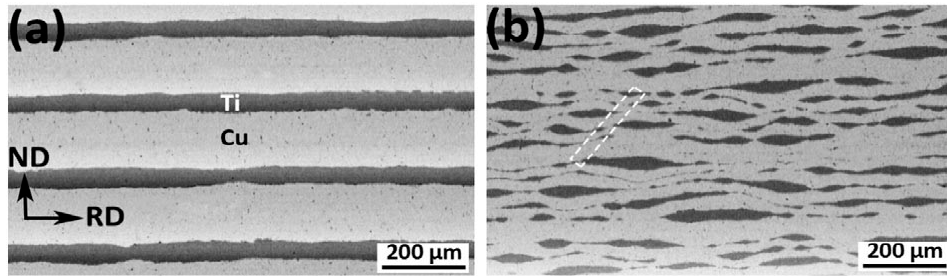
Figure 7. SEM micrographs of the ARB processed Cu/Ti bimetal composites after ( a ) 1 cycle, ( b ) after 3 cycles. Reprinted with permission from ref. [86]. Copyright 2017 Elsevier.